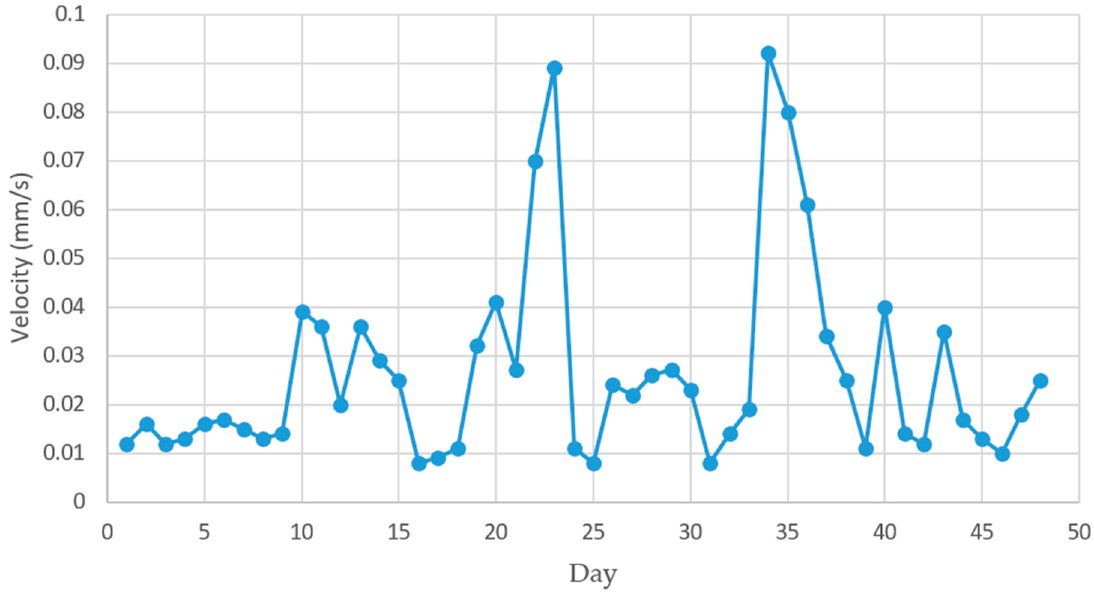
Figure 10. Maximum daily velocities recorded in the foundations of the historical site.